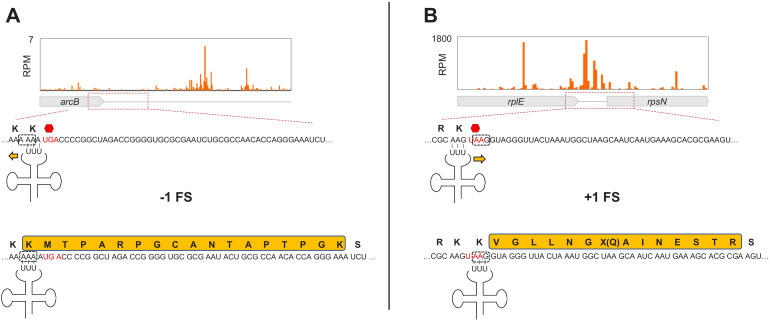
Possible scenarios for stop codon bypass via frameshifting in Api-treated cells.(A) Top: Ribosome footprints density downstream of the arcB ORF in Api-treated cells. Bottom: Inability of the ribosome to rapidly terminate translation at the arcB UGA stop codon (red), due to Api-induced RF2 depletion, may allow for to a backward shift of the peptidyl-tRNALys occupying the last arcB sense codon AAA (boxed) within the slippery sequence, landing in an identical (−1) frame codon (boxed). (B) Top: Ribosome footprints density in the region downstream of the rplE ORF in Api-treated cells. Bottom: Slow termination of translation at the rplE UAA stop codon (red), may lead to repairing of the peptidyl-tRNALys occupying the last rplE sense codon AAG to the nearby identical codon in a (+1) frame (boxed). In (A) and (B), the amino acid sequences of the tryptic peptide identified by shotgun proteomics in cells treated with Api are highlighted in yellow. Note that the stop codon within the (+1) frame downstream of rplE is bypassed by the misincorporation of a near-cognate Gln-tRNA(UUG). Also of note, the same tryptic peptide as the one encoded in the mRNA segment downstream of the arcB gene could be also identified in untreated cells.